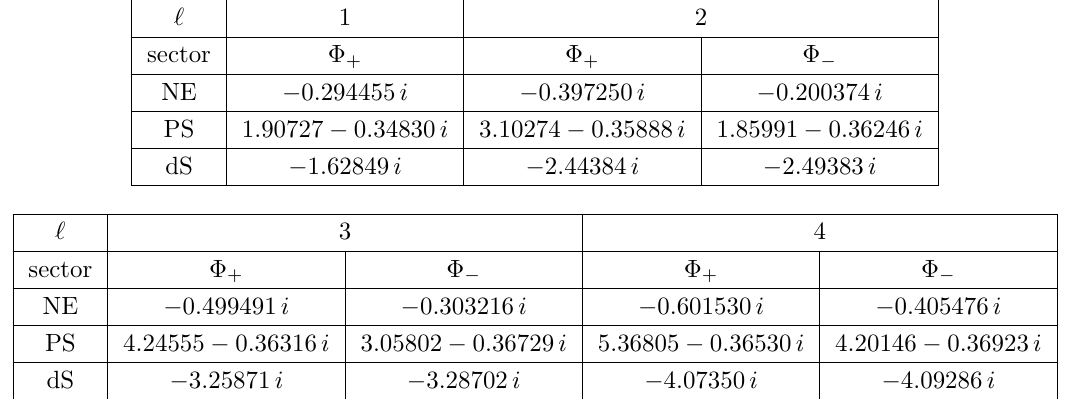
Table 1 . Gravitoelectromagnetic quasinormal mode frequencies ! r c of a RNdS black hole with y + = 0 : 2 and Q=Q ext = 0 : 98. The rows of the table(s) refer to the near-extremal (NE), photon sphere (PS) and de Sitter (dS) families of modes. Only the fundamental ( n = 0) mode is shown in each case. Our analytical near-horizon calculation (5.25) gives ! r c j NE = (cid:0) 0 : 280281 i ( ‘ = 1, (cid:8) + ), ! r c j NE = (cid:0) 0 : 378483 i ( ‘ = 2, (cid:8) + ) and ! r c j NE = (cid:0) 0 : 191033 i ( ‘ = 2, (cid:8) (cid:0) ), ! r c j NE = (cid:0) 0 : 476091